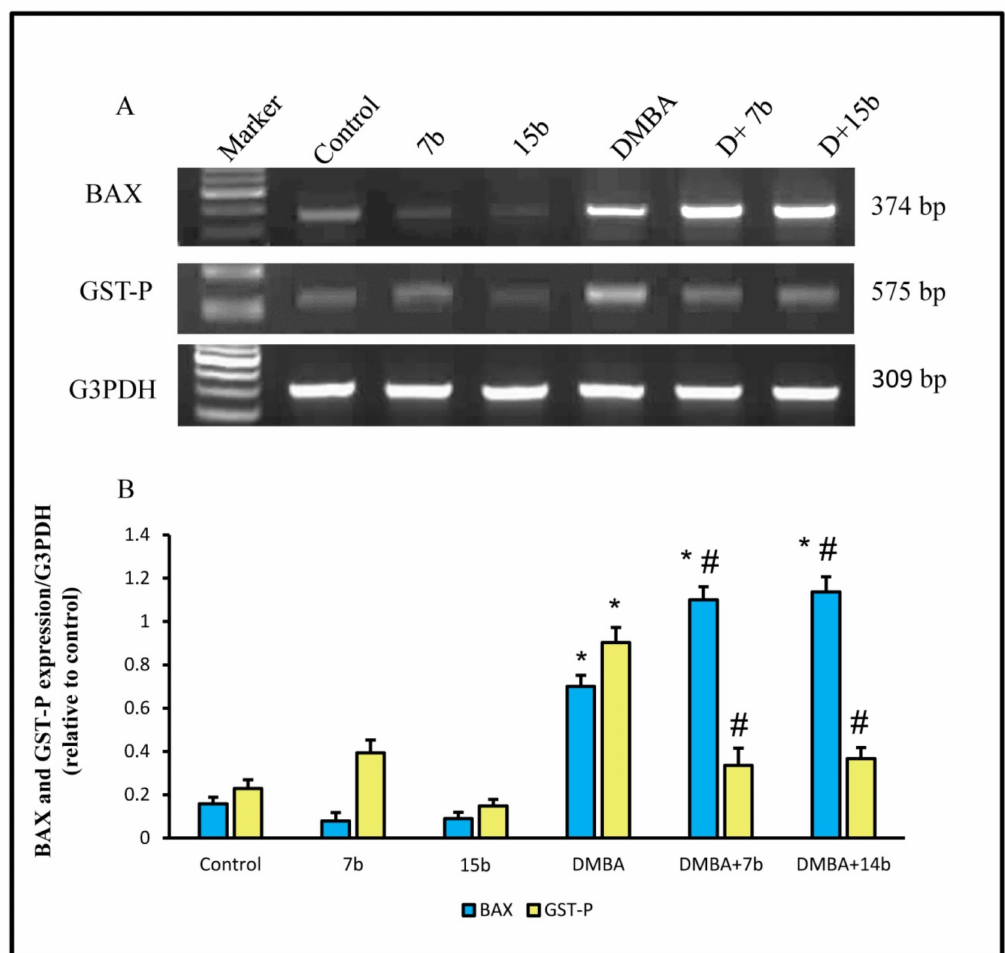
Figure 1. Effect of 7b and 15b compounds on changes in gene expression induced by DMBA in breast. Values are means ± SE of 10 rats. * p < 0.05 vs. control group; # p < 0.05 vs. DMBA group. ( A ) Upper panels are mRNA expression of examined gene. ( B ) Lower columns are densitometric analysis of gene